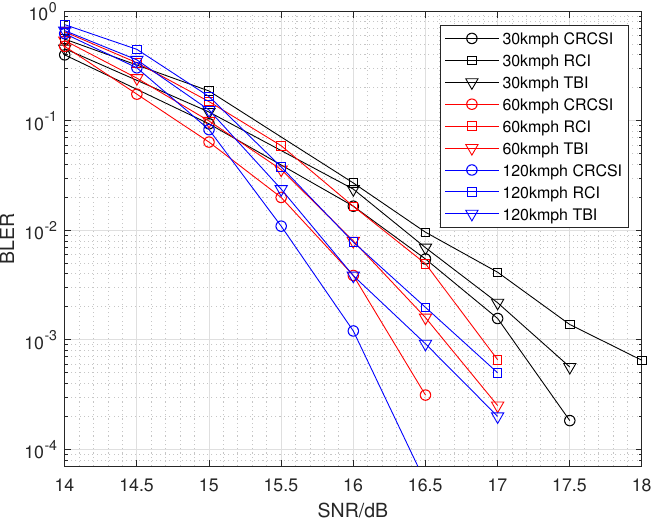
Figure 7. Comparison for different